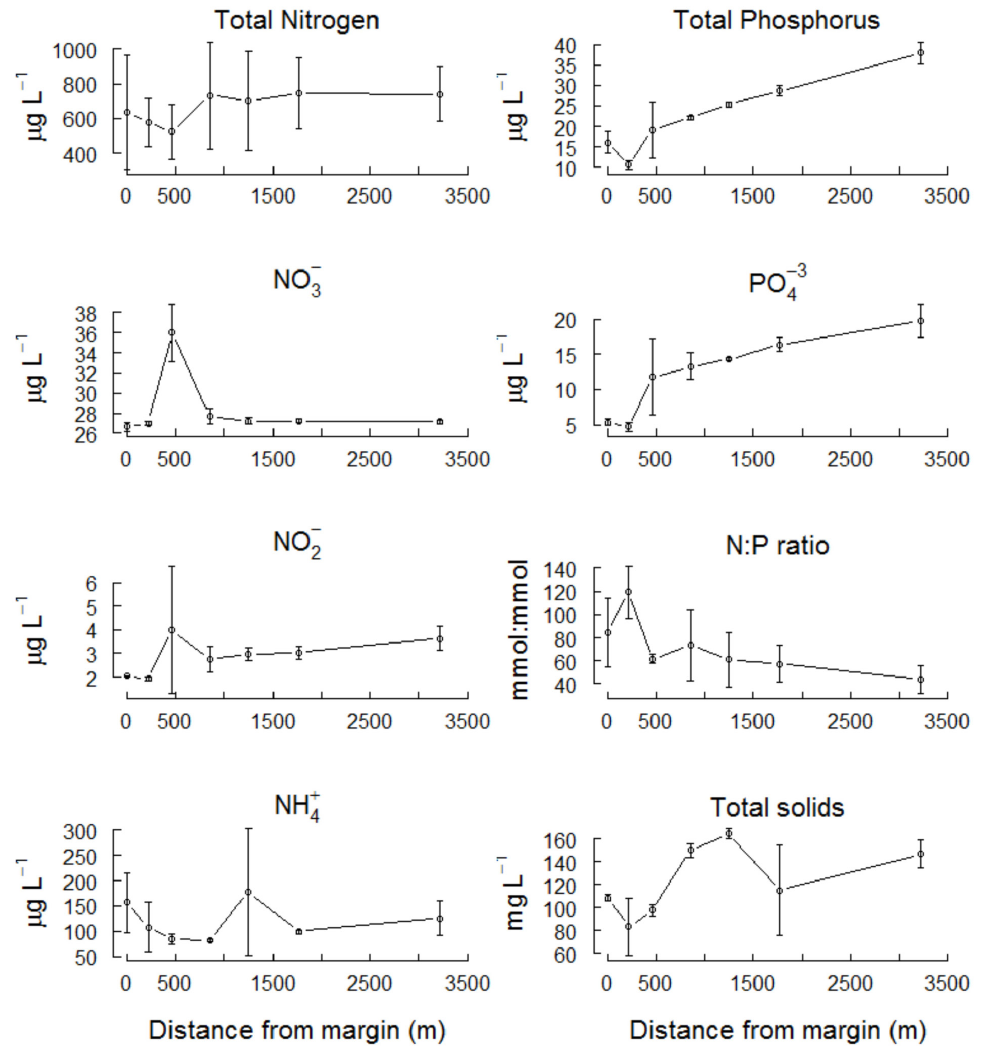
Figure 2. Gradient of inorganic nutrients and total solids along a transect running from a littoral macrophyte dominated zone to a phytoplankton dominated pelagic zone in Lake Mangueira. Bars represent standard deviations (n =